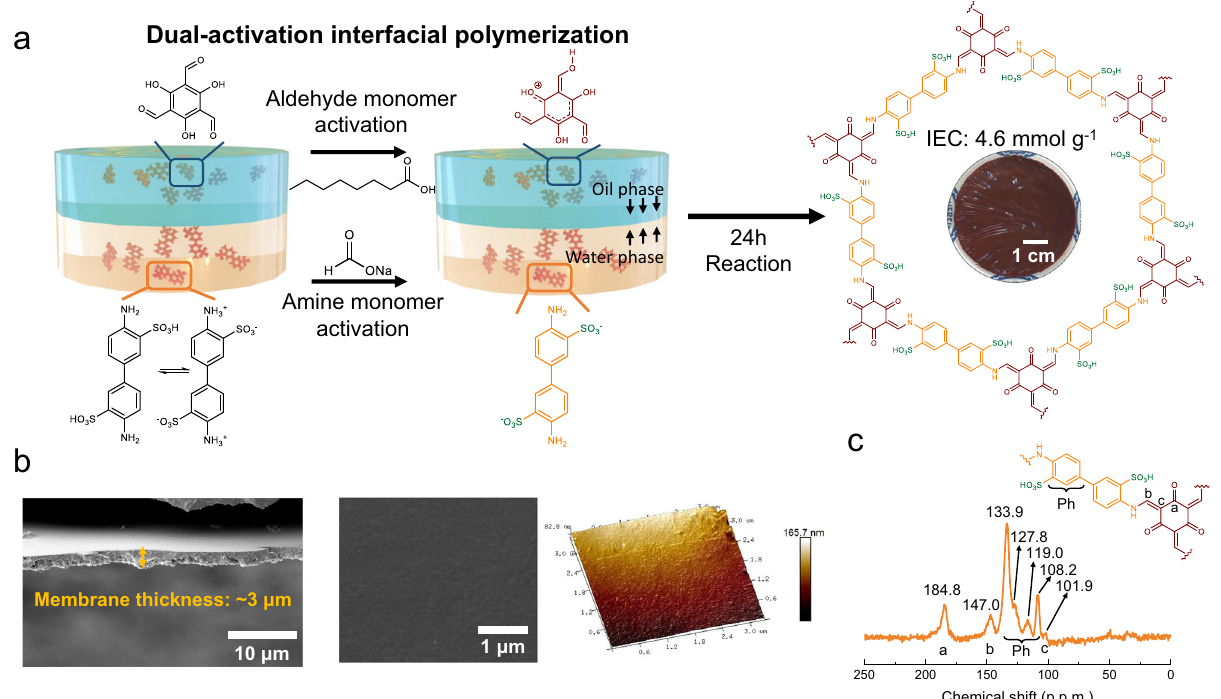
Fig. 1 Membrane fabrication. a Schematic illustration of the TpBD-(SO 3 H) 2 iCOFMs fabrication process. b Cross-sectional SEM image, surface SEM image and surface AFM images of the TpBD-(SO 3 H) 2 iCOFMs. c Solid-state 13 C NMR spectra of the TpBD-(SO 3 H) 2